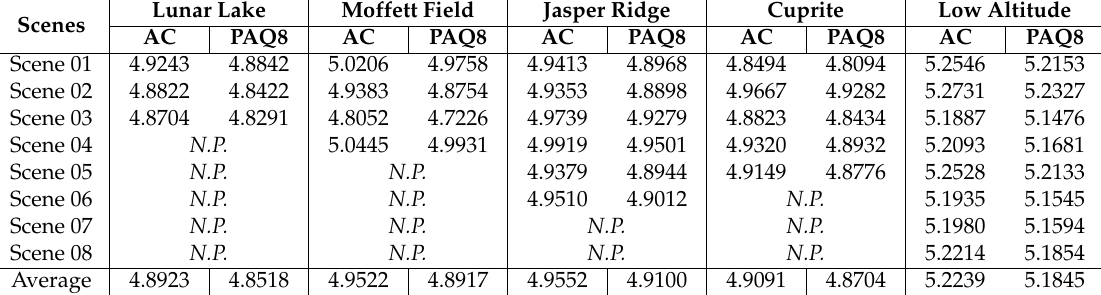
Table 7. Achieved results by using the following parameters: N “ 16, B “ 3.